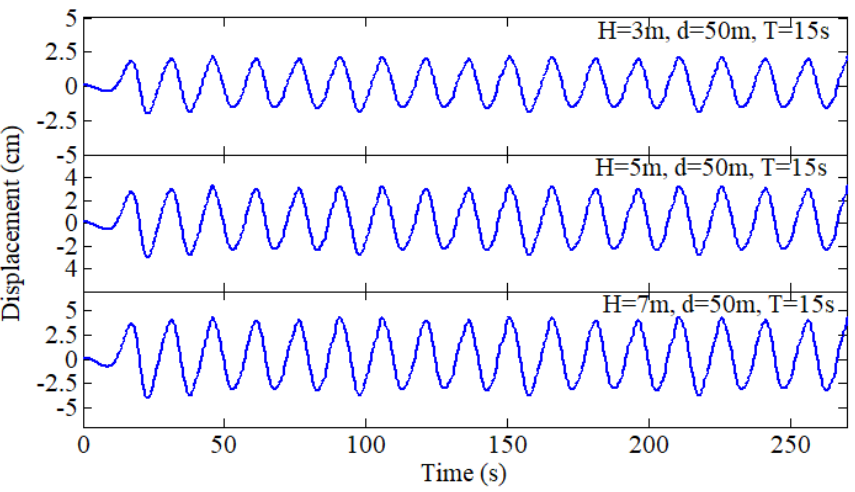
Figure 13. Time history of the horizontal displacement at the top of the jack-up platform under three conventional wave conditions.